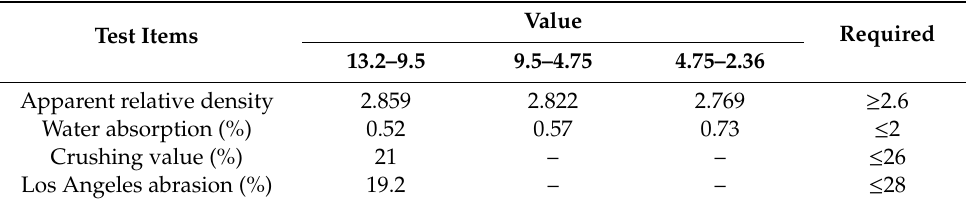
Table 2. Physical Properties of Coarse Aggregates.